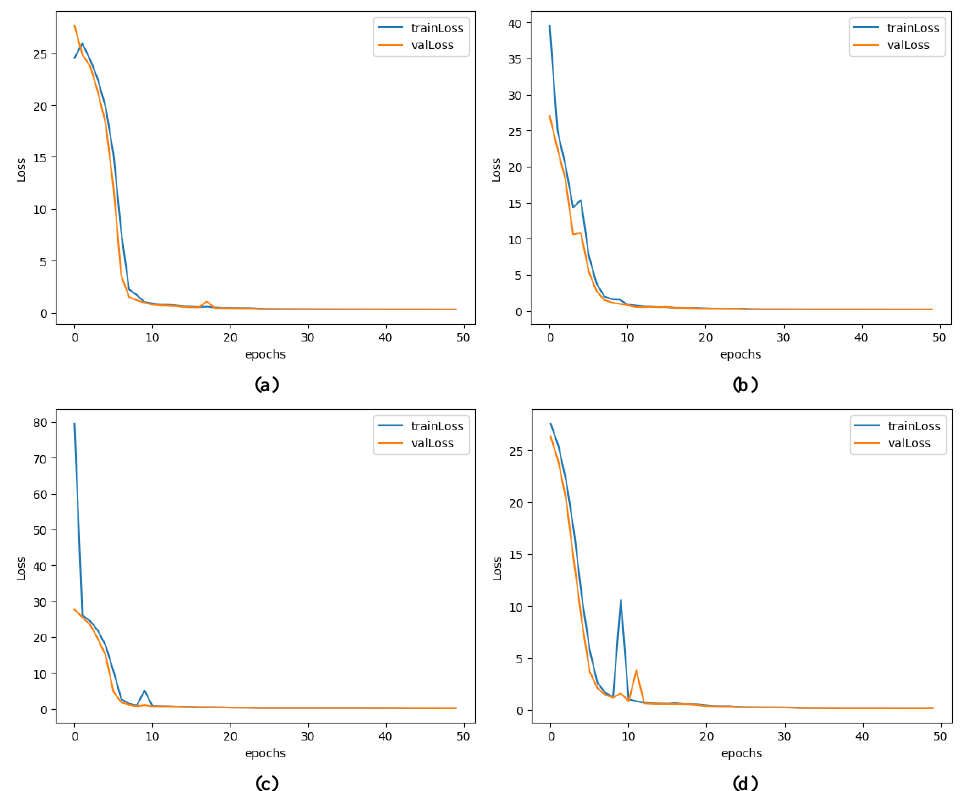
Figure 8. Training history of